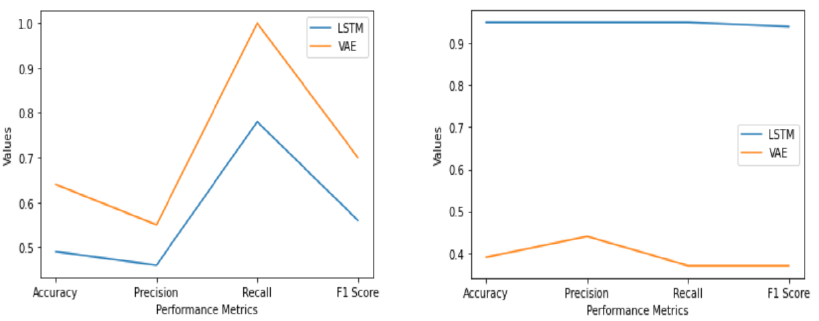
Figure 17. Validation phase for two-class and six-class and testing phase for two-class and six- class respectively.